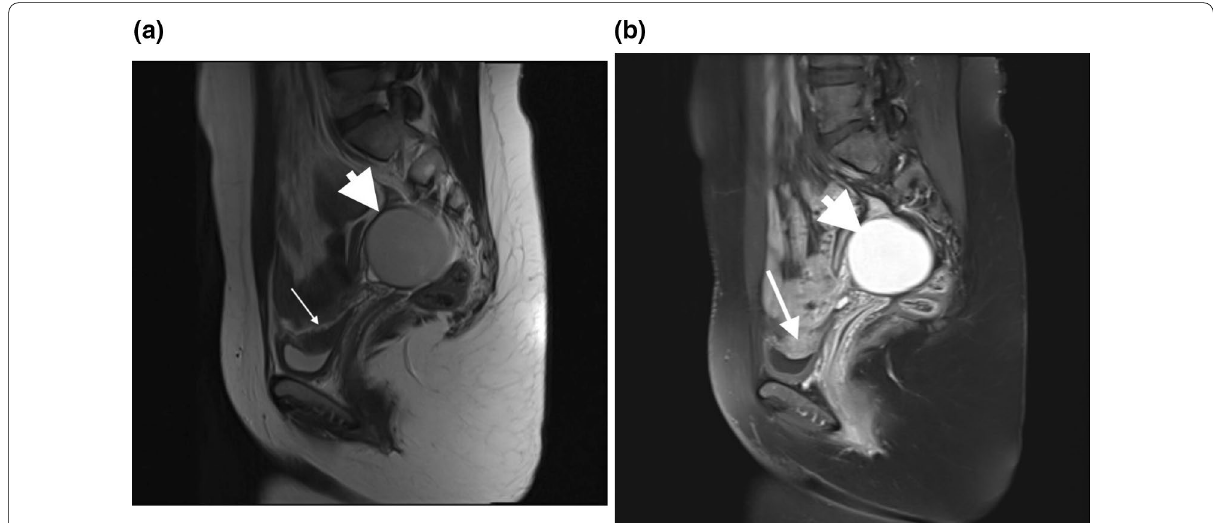
Fig. 1 a T2 weighted sagittal MRI image without contrast showed a hyposignal plaque on the dome of the bladder and a typical endometrioma in the ovary (hyposignal in T2). b T1 weighted sagittal fat-suppressed image with contrast in the same patient showed enhancement of the plaque proved to be endometriosis in surgery, endometrioma typically hypersignal in T1